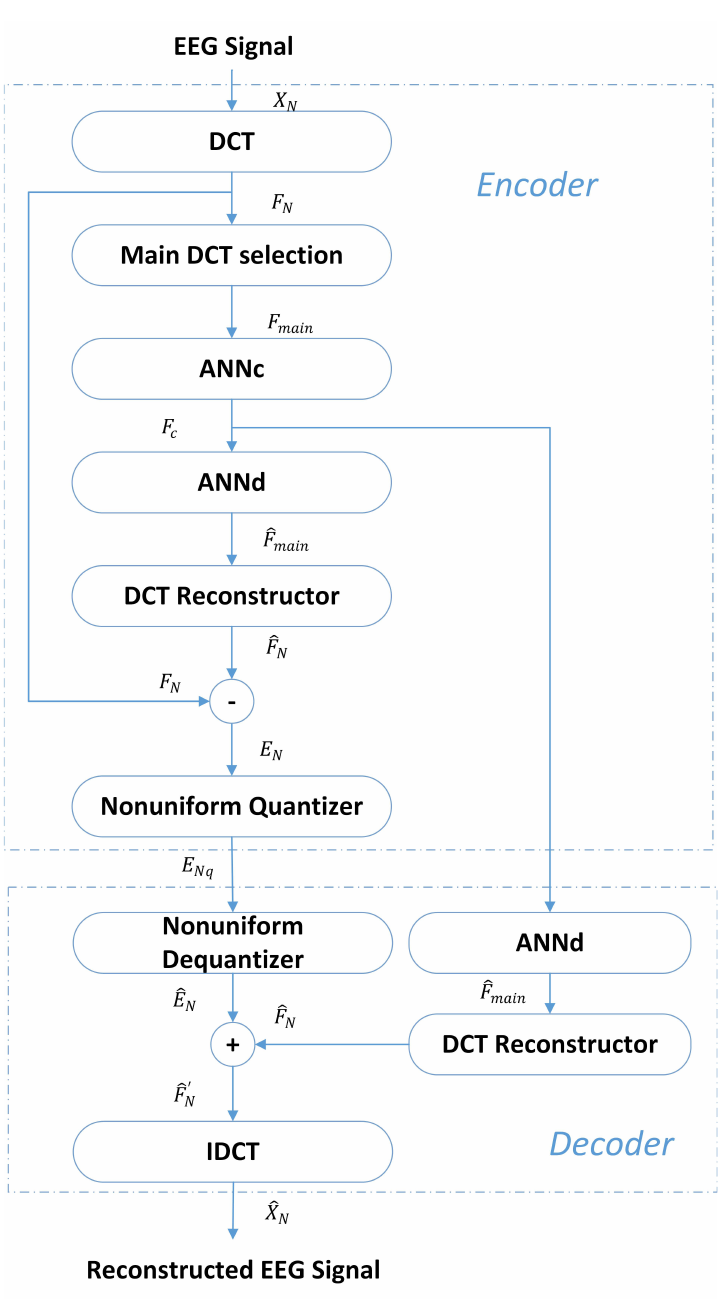
Figure 2. System structure